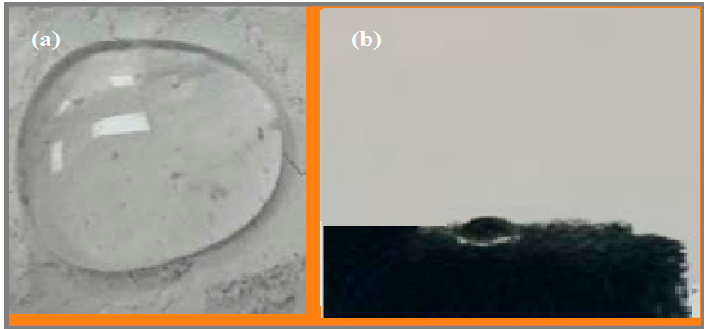
Figure 10. Water droplet on the surface of ( a ) hydrophobic sand and ( b ) hydrophobic polyurethane (PU) sponge modified with HSNP-2 (prepared using 40 wt.% ASAS).